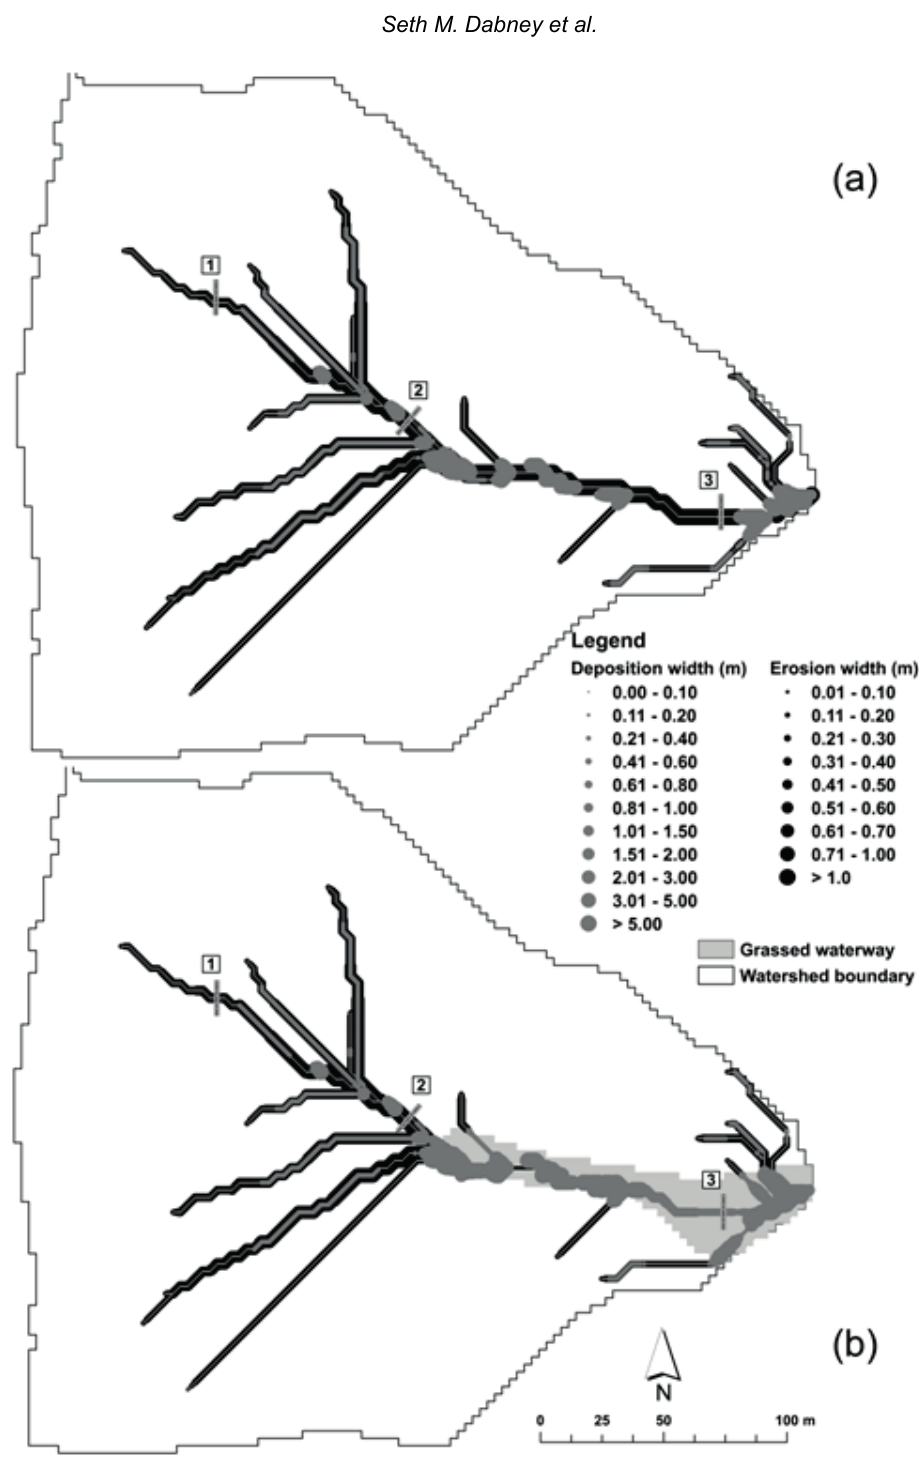
Fig. 3 The maximum widths of EphGEE-predicted eroded channels and sediment deposits within Watershed 11 at Treynor, Iowa, USA, in response to runoff events predicted by RUSLE2 when simulated: (a) without a grassed waterway, and (b) with a grassed